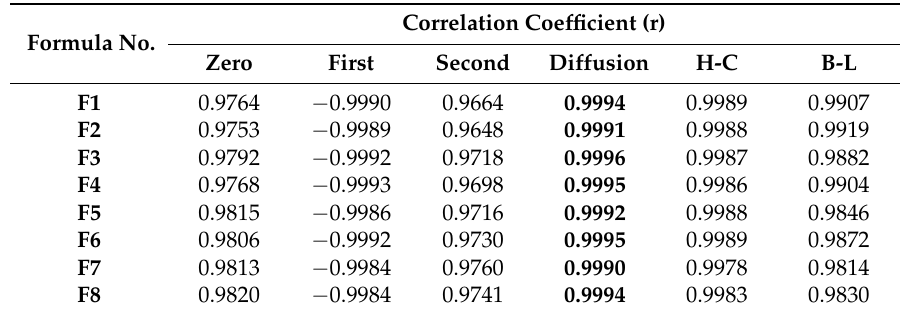
Table 5. The calculated correlation coefficients for the in-vitro release of MIC from Transfersomes employing different kinetic orders or